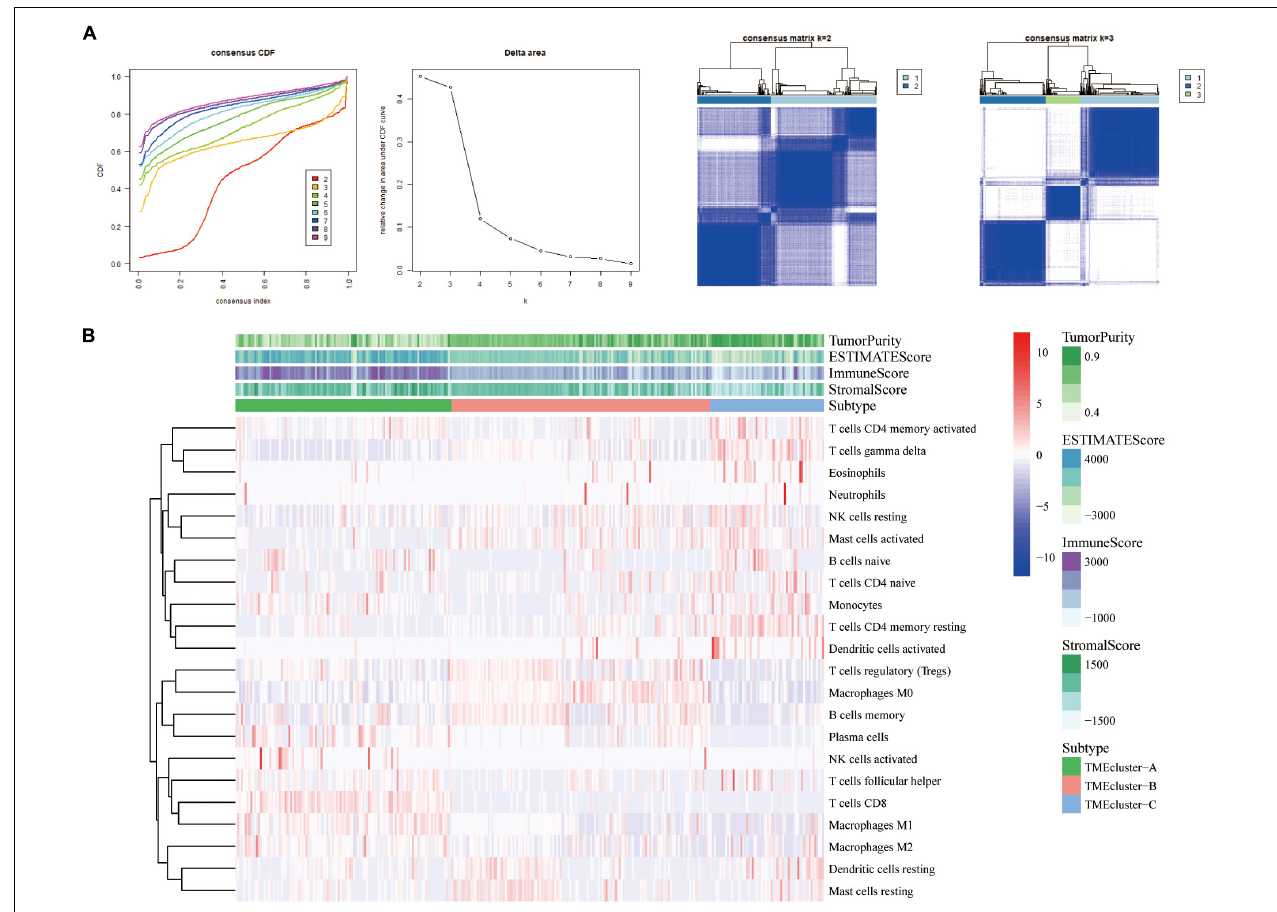
FIGURE 2 | Three types of SKCM patients in the GEO database based on TIICs infiltration. (A) Hierarchical clustering determined the number of clusters of the immune cell infiltration patterns of 310 SKCM patients in the GEO database (GSE8401, GSE35640, GSE15605, and GSE46517) and repeats 1,000 times to ensure the stability of the classification. (B) Heatmap displaying the expression of tumor-infiltrating immune cells in SKCM patients from GEO database was